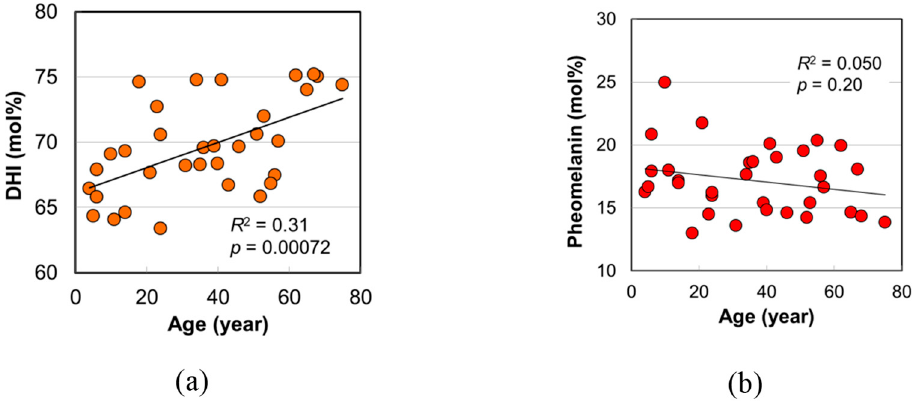
Figure 4. The age dependences of melanin components in Japanese female hairs. ( a ) DHI mol% in eumelanin of hair. ( b ) Pheomelanin mol% in hair. The coefficient of determination and the p -value are shown in each figure.